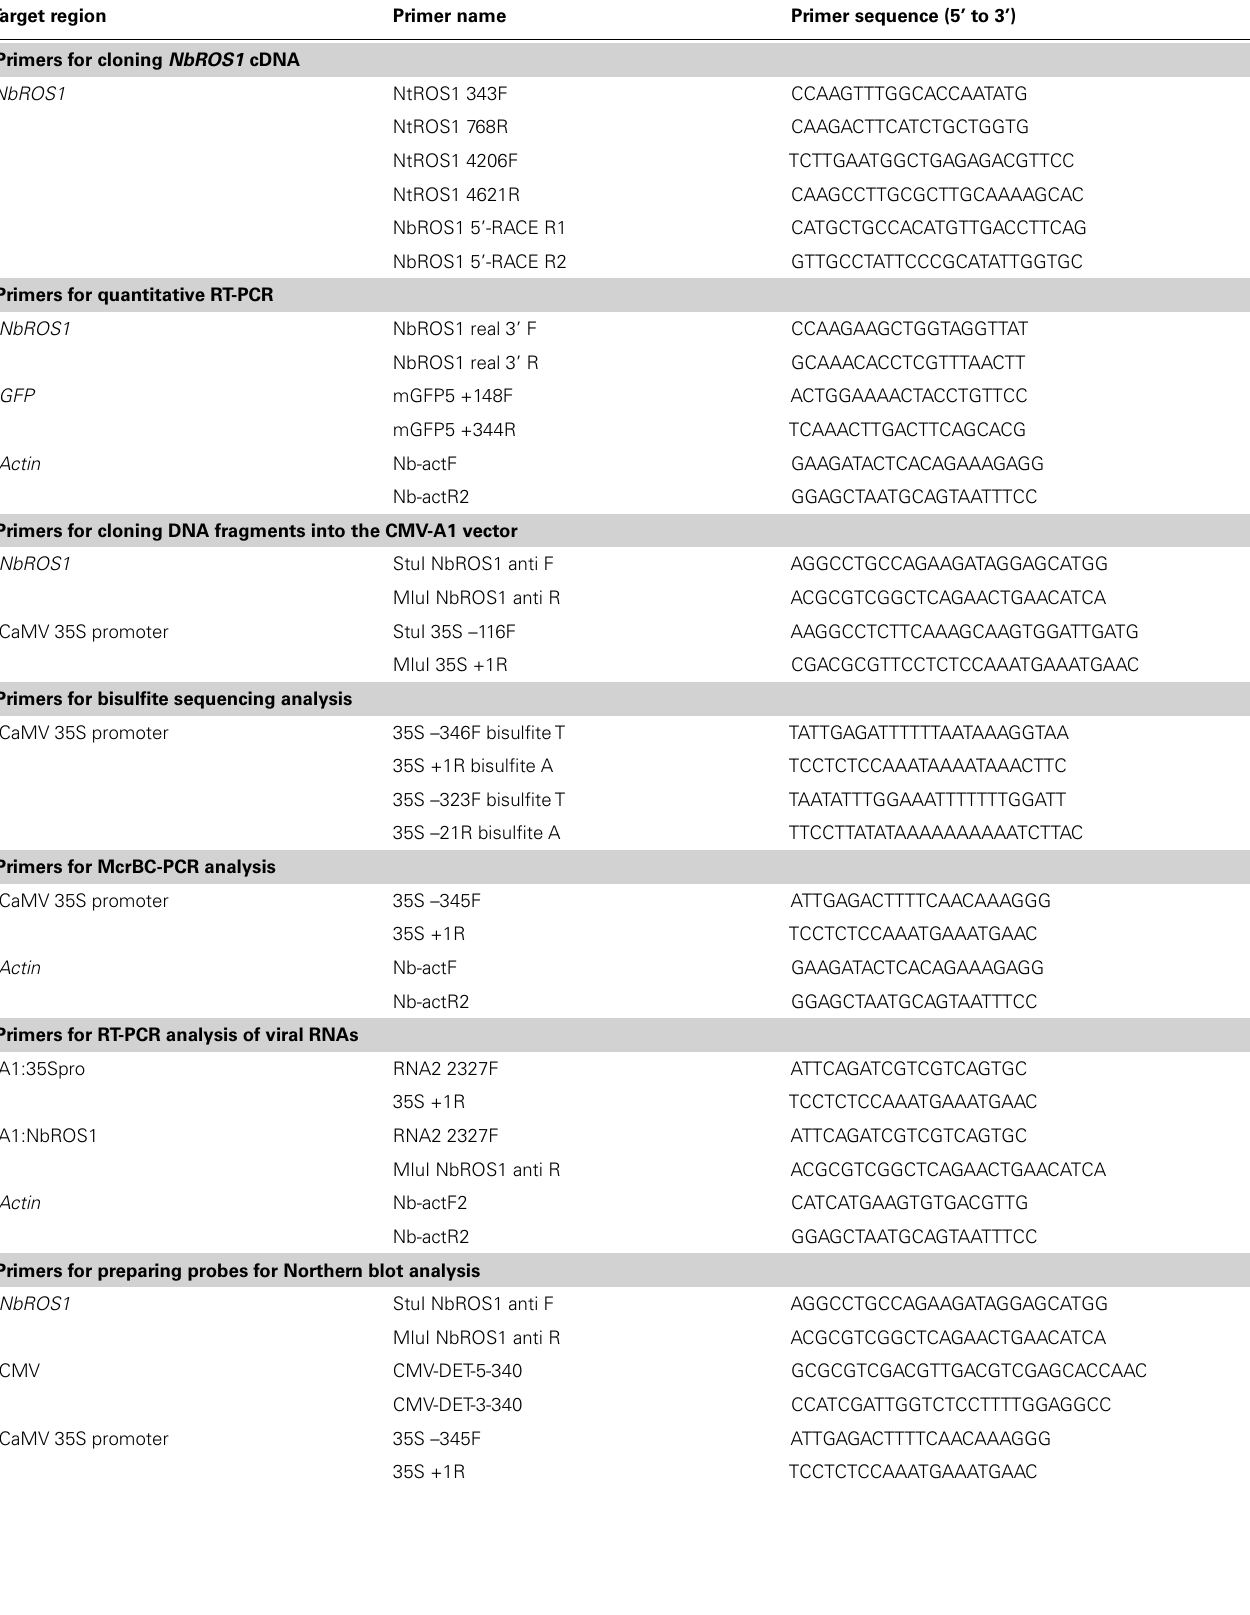
TableA1 | List of PCR primers used in the present